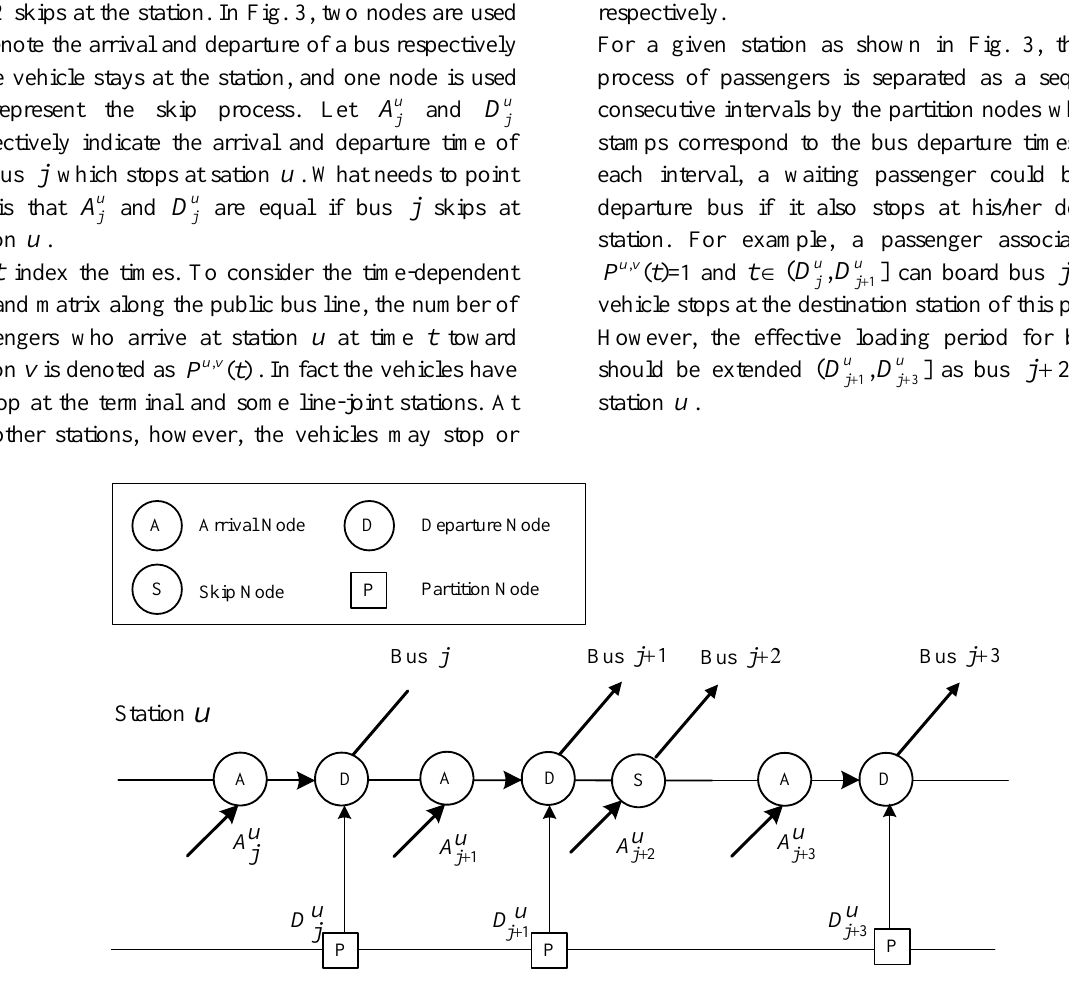
Fig.3 Illustration of transit operation process at a